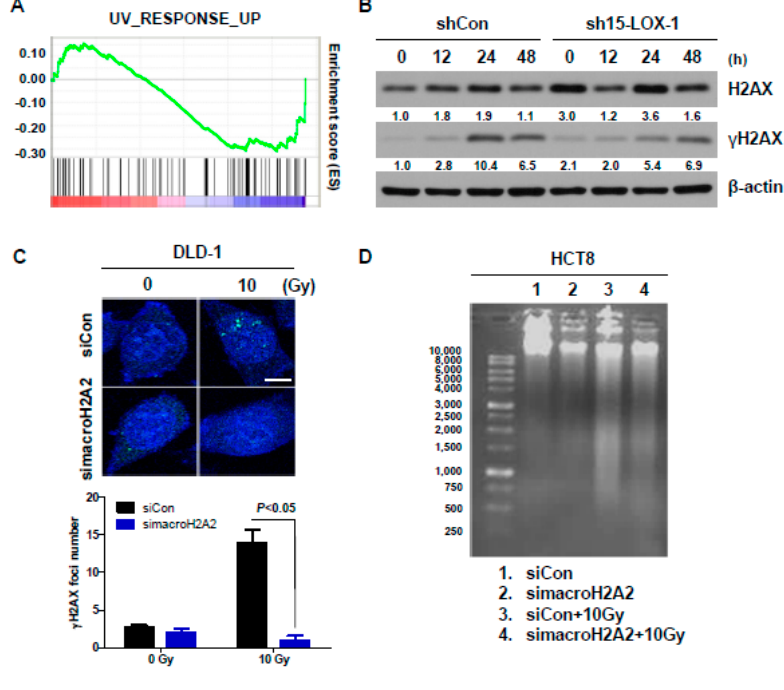
Figure 5. Cont. Figure 5.